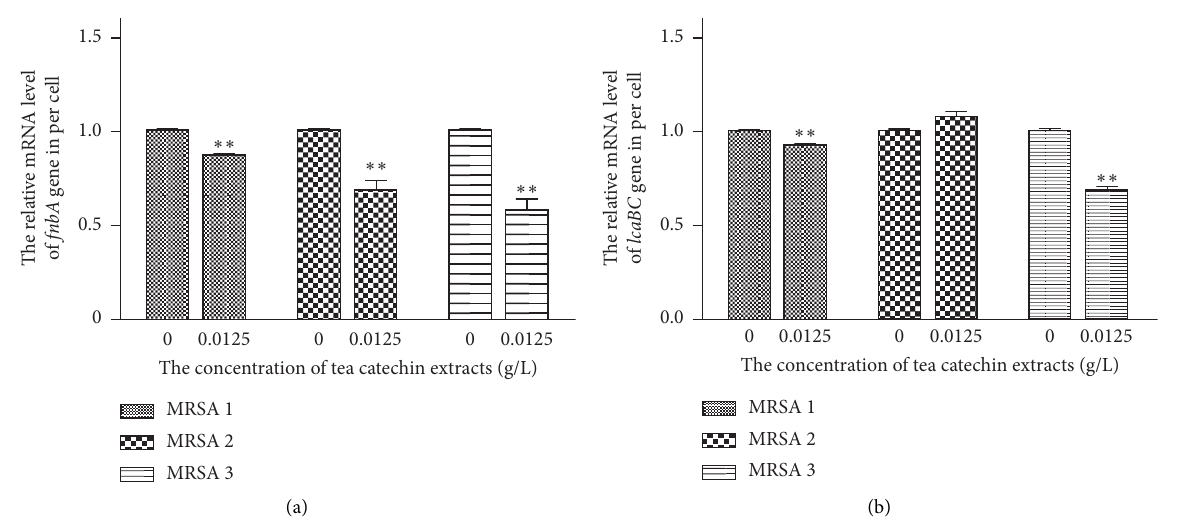
Figure 4: fnbA and icaBC expression in MRSA isolates treated with tea catechin extracts. MRSA isolates were incubated with 0.0125g/L tea catechin extracts overnight. Real-time quantitative PCR was used to detect the relative mRNA level of fnbA (a) and icaBC (b). Data were mean ± SEM of three independent experiments ( ∗ P < 0 . 05 and ∗∗ P < 0 .